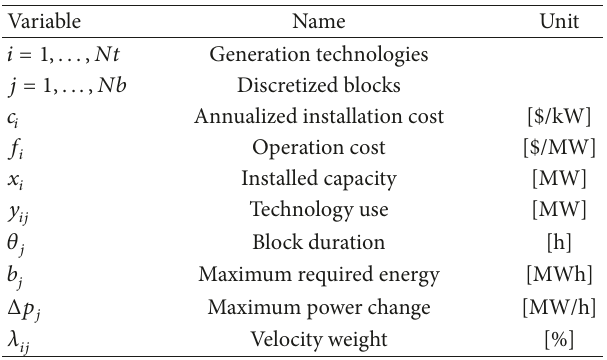
Table 2: Variable